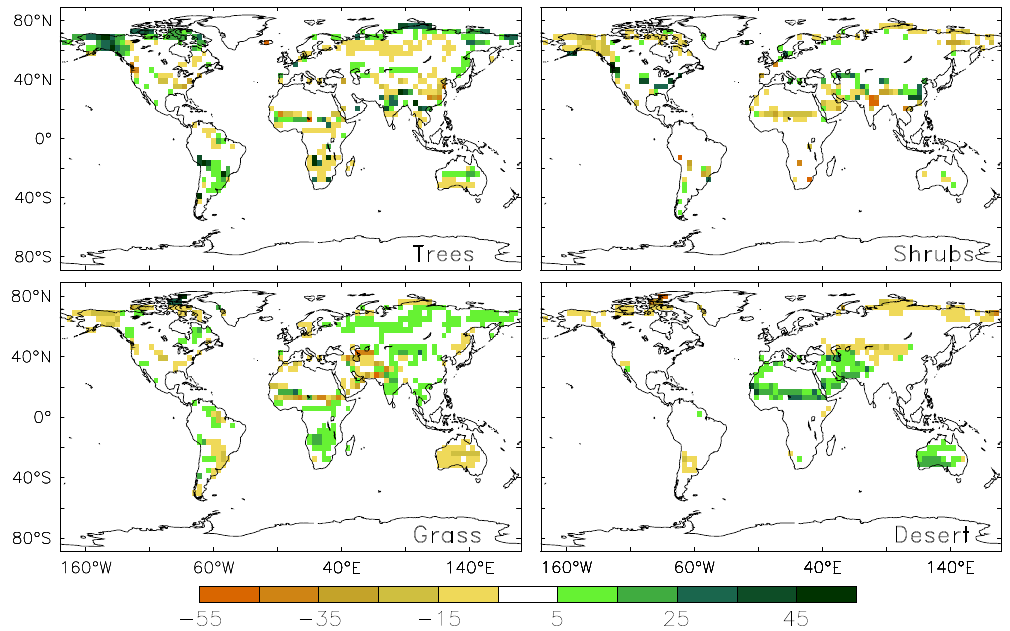
Fig. 5. Changes in absolute vegetation cover in [%] from 2120 (averaged over the period from the year 2090 until 2119) until 2300 (averaged over the period from the year 2270 until